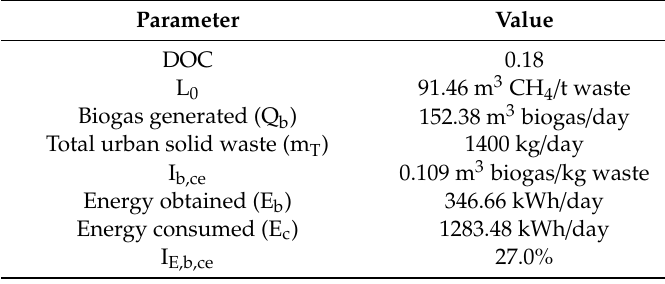
Table 2. Circular economy indicators for biogas production. DOC, degradable organic